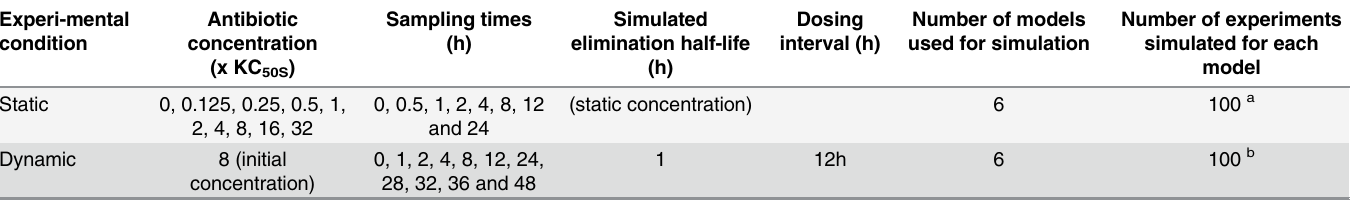
Table 2. Conditions used for Monte Carlo simulations of static and dynamic in vitro infection models. Experi-mental condition